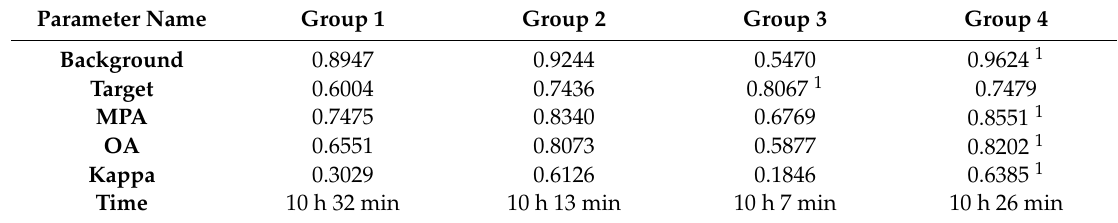
Table 6. Classification accuracy of di ff erent groups under extremely weak signal.